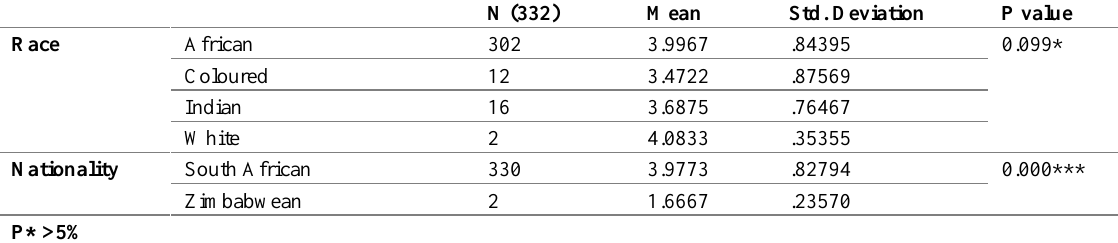
Table 3: ANOVA test of race, nationality and entrepreneurship intention N (332) Mean Std.